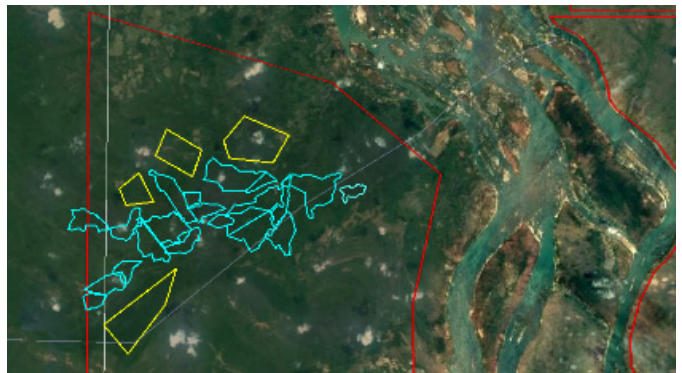
Figure 8. Community resin forest shapefiles. Red is project boundary, white N ‐ S line is PLWS boundary, white E ‐ W line is provincial boundary (Steung Treng to the north, Kratie to the south). Blue are mapped forests and yellow are remaining areas to be mapped. GoogleEarth screen shot by author. Forests 2017 , 8 , 47